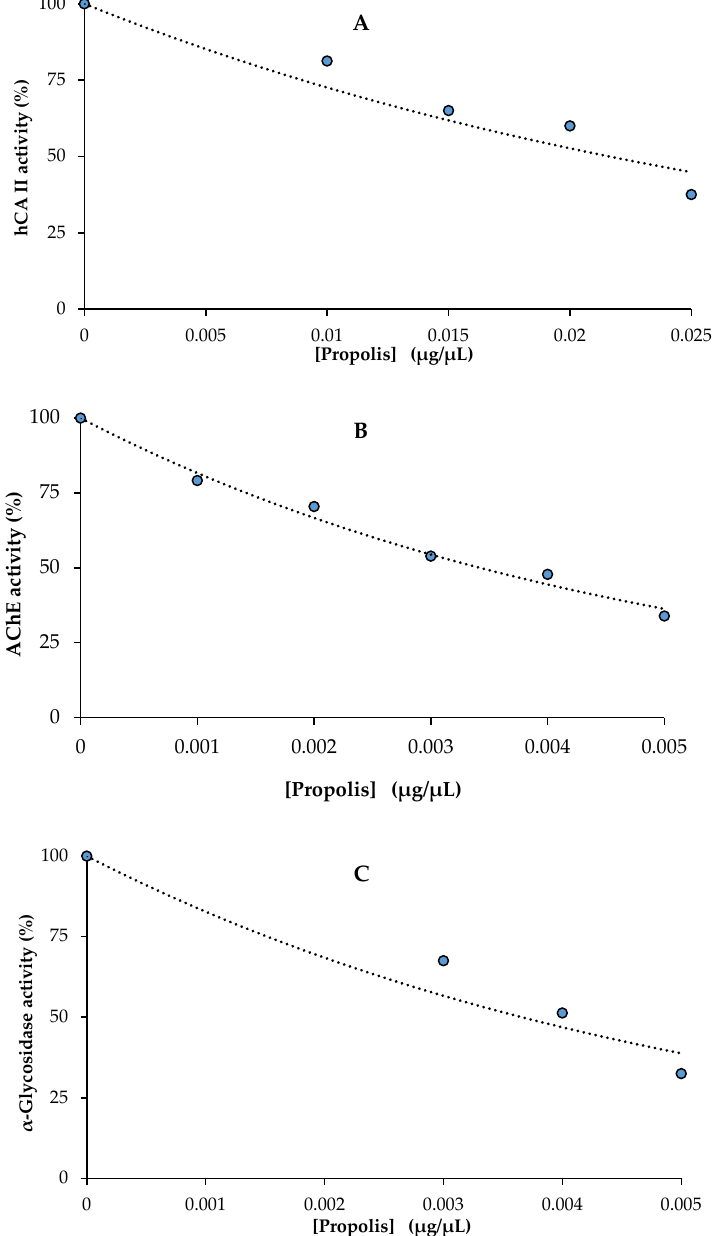
Figure 2. The half-maximal inhibitory concentration (IC 50 ) graphs of propolis against human carbonic anhydrase II (hCA II) ( A ), acetylcholinesterase (AChE) ( B ) and α -glycosidase ( C ) enzymes.